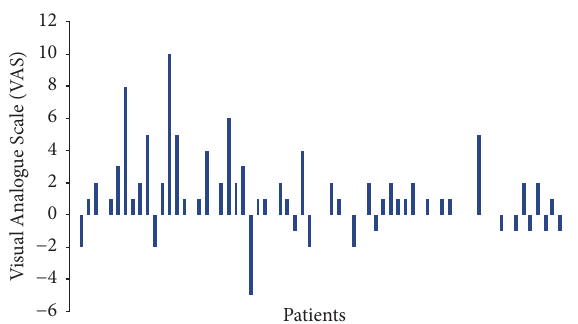
Figure 2: Variation in Visual Analogue Scale (VAS) between Wand and traditional local anesthesia. There was a significant mean reduction of 1.09 VAS point (median 1) with the Wand compared with traditional syringe ( 𝑝 = 0.0003 ).